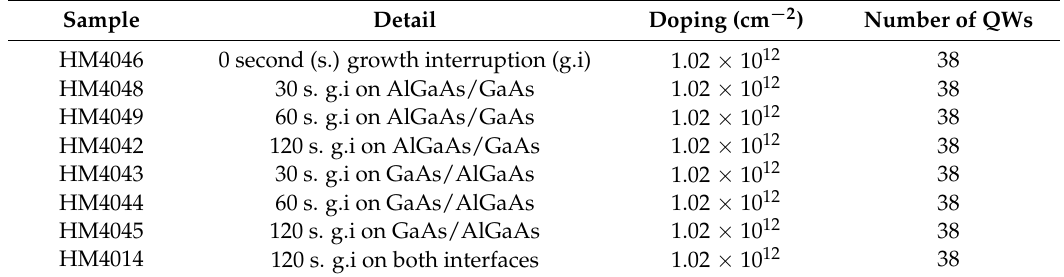
Table 2. The second set of samples for studying the broadening mechanism of interface